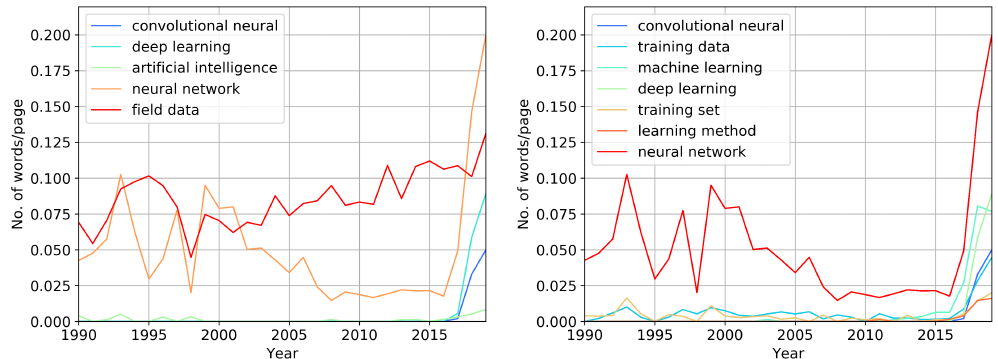
Figure 10. “Neural network”-related bigrams. We display the phrase “field data” for